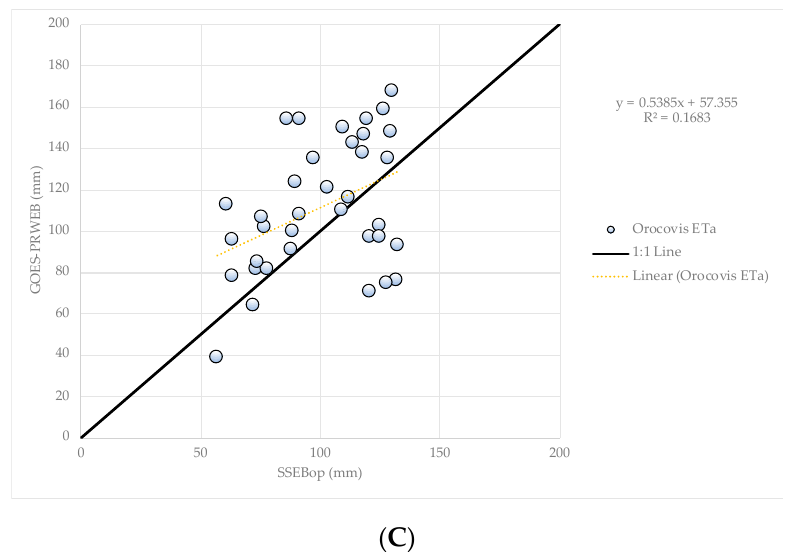
Figure 13. GOES-PRWEB versus SSEBop ET a . Mayaguez ( A ), Guanica ( B ) and Orocovis ( C ). Data represent monthly ET a